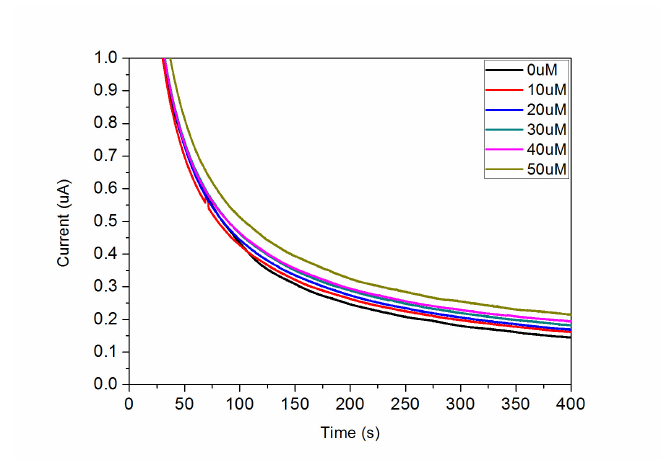
Figure 9. Amperometric response of the disposable biosensor to different DG concentrations. Test medium was 0.1 M pH 8.3 phosphate buffer. Applied potential was +0.5 V versus Ag/AgCl.